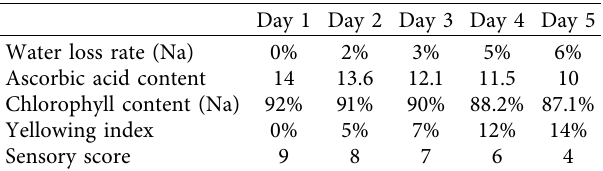
Table 4: Experimental data table of vegetable preservation based on ozone micro-nano bubble preservation